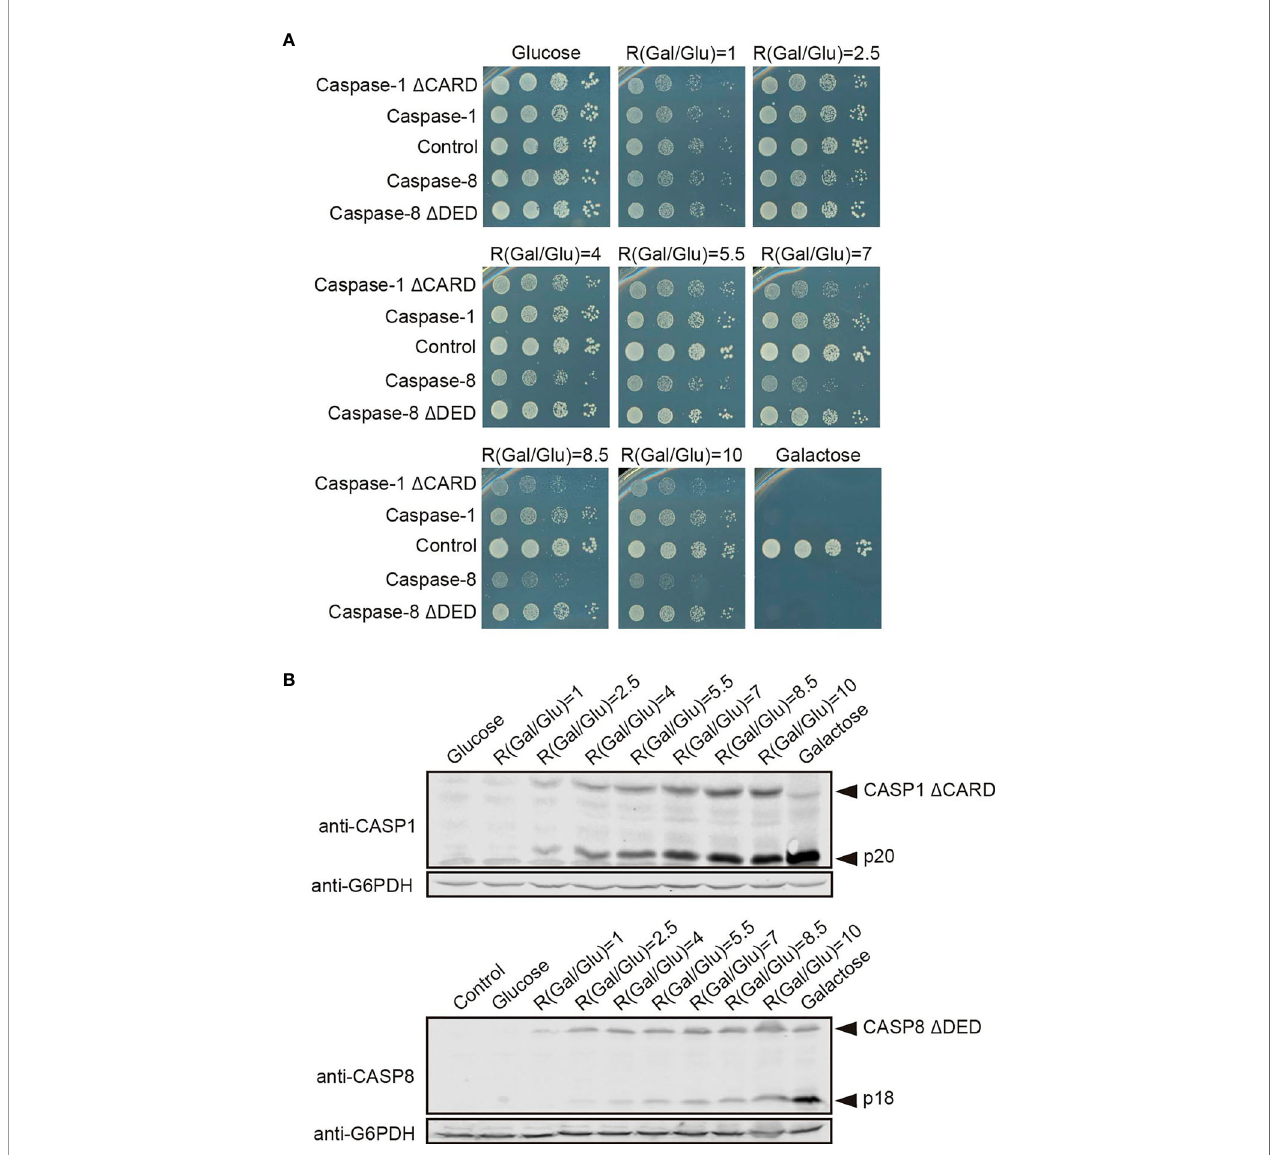
FIGURE 8 | The modulation of Caspase-1 D CARD and Caspase-8 D DED expression under the GAL1 promoter con fi rms their opposite effect on caspase activity. (A) Spot growth assay carried out as in Figure 6B but with BY4741 strain bearing pAG413-caspase-1 and pAG413-caspase-8, or plasmids with their respective mutant lacking DD pAG413-caspase-1 D CARD and pAG413-caspase-8 D DED. pAG413 empty vector was used as a negative control. A representative assay from three different experiments with distinct transformants is shown. (B) Immunoblotting carried out as in Figure 6A but with BY4741 strain bearing pAG413-caspase-1 D CARD (upper panel) and pAG413-caspase-8 D DED (lower panel). pAG413 empty vector was used as a negative control. Membranes were hybridized with anti- caspase-1 and anti-caspase-8 antibody. Anti-G6PDH antibody was used as a loading control. A representative assay from two different experiments with different transformants is